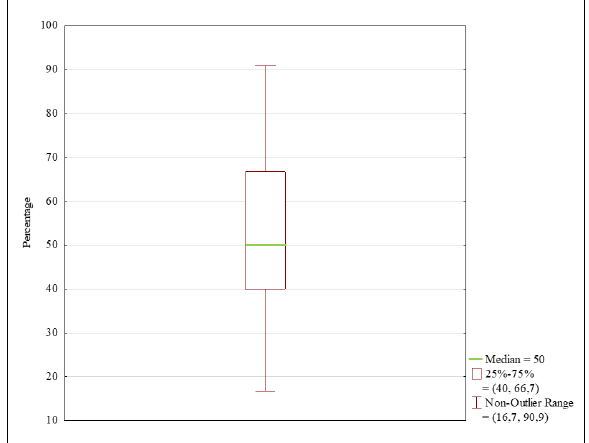
Percentage contribution of e-waste to total income for respondents collecting both e-waste and other